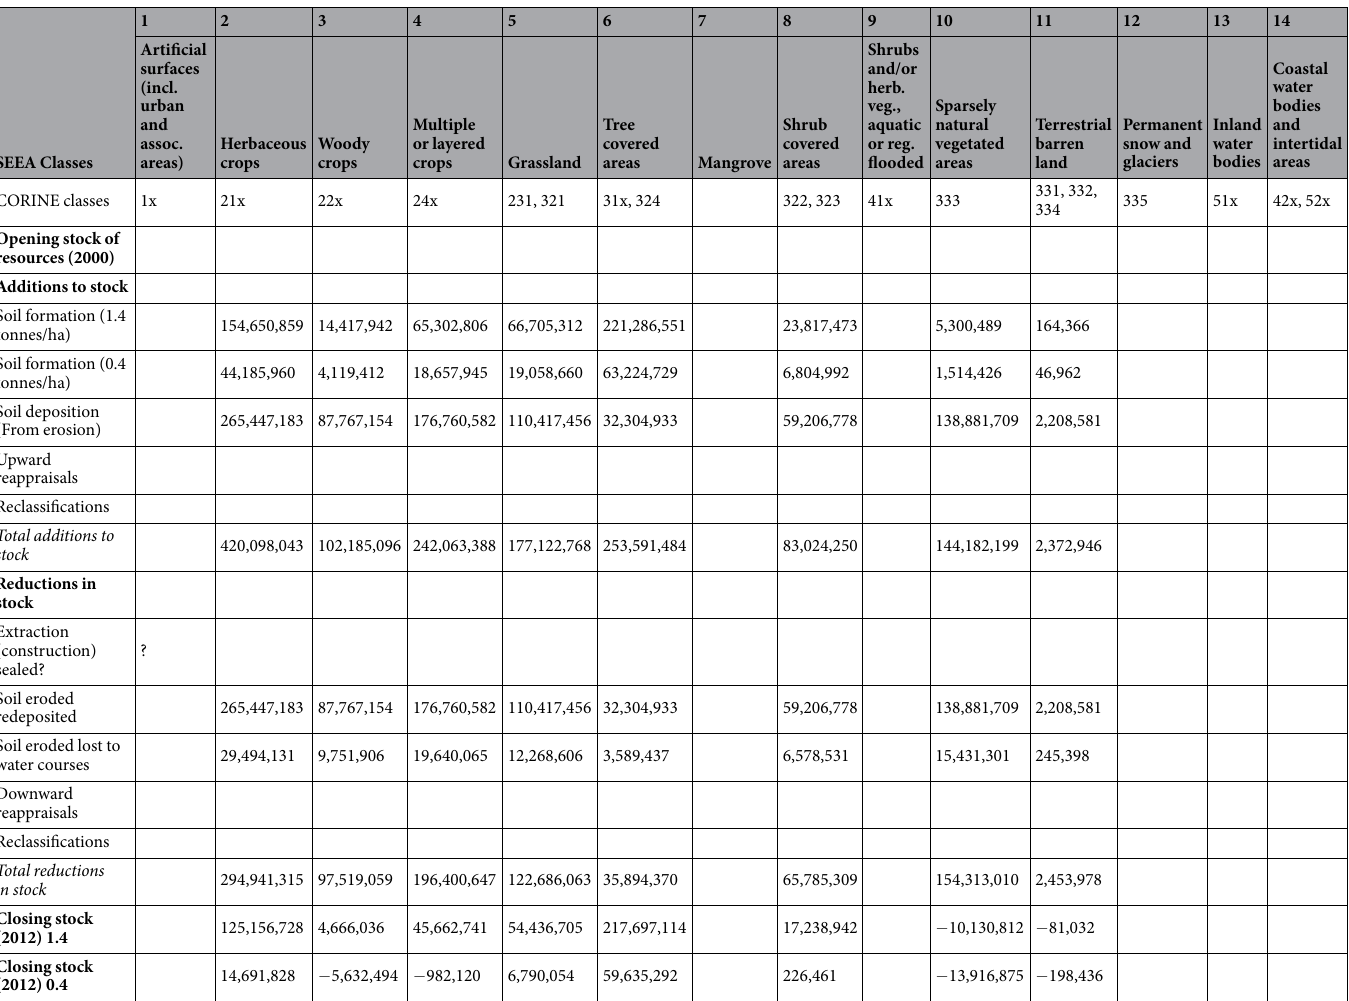
Table 3. Mass account for soil stock, prototype biophysical account table for EU soil formation and erosion between 2000 and 2012. Note that soil erosion estimates are limited to rill and sheet erosion and are likely a lower